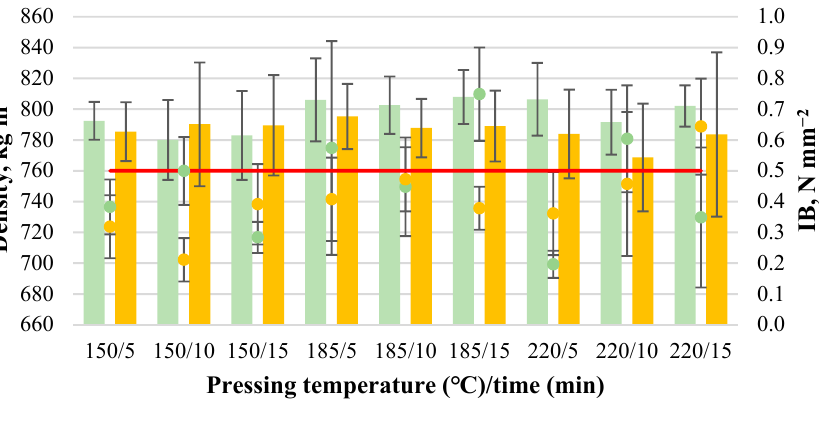
Figure 2. Density and IB changes of binder-less boards with a density of 800 kg m − 3 depending on the crop and pressing variables.